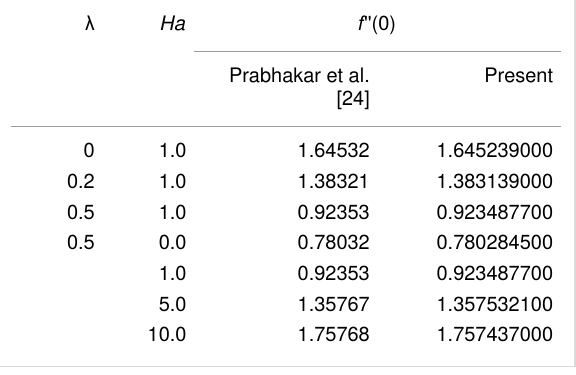
Table 3: Comparison between the computed values of f ''(0) and the results given by Prabhakar et al. [24]. λ Ha f